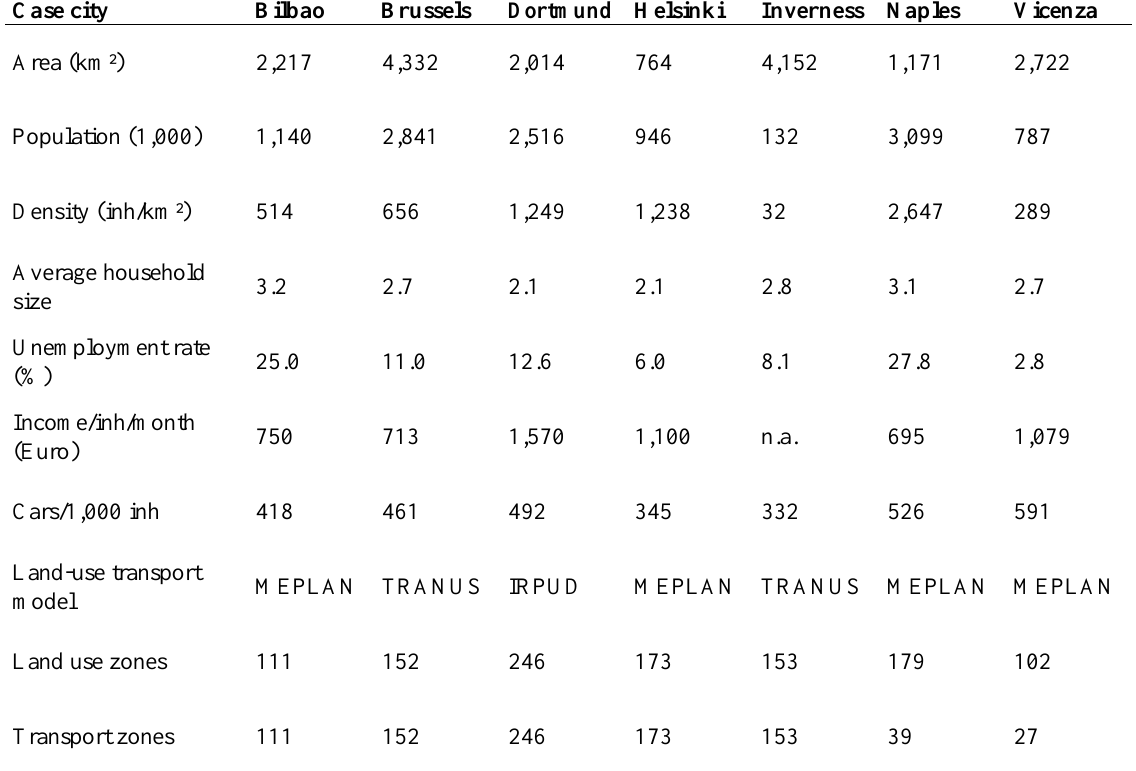
Table 2. Case city regions and land-use transport